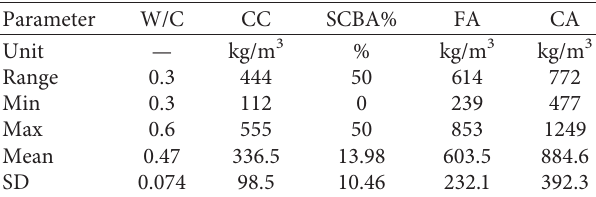
Table 1: Statistics of the input parameters.